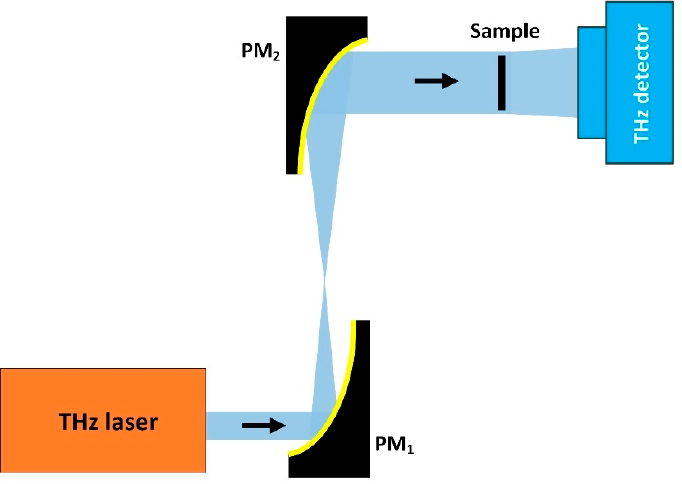
Figure 8. Schematic layout of the in-line CW THz digital holography (CW TDH) scheme.